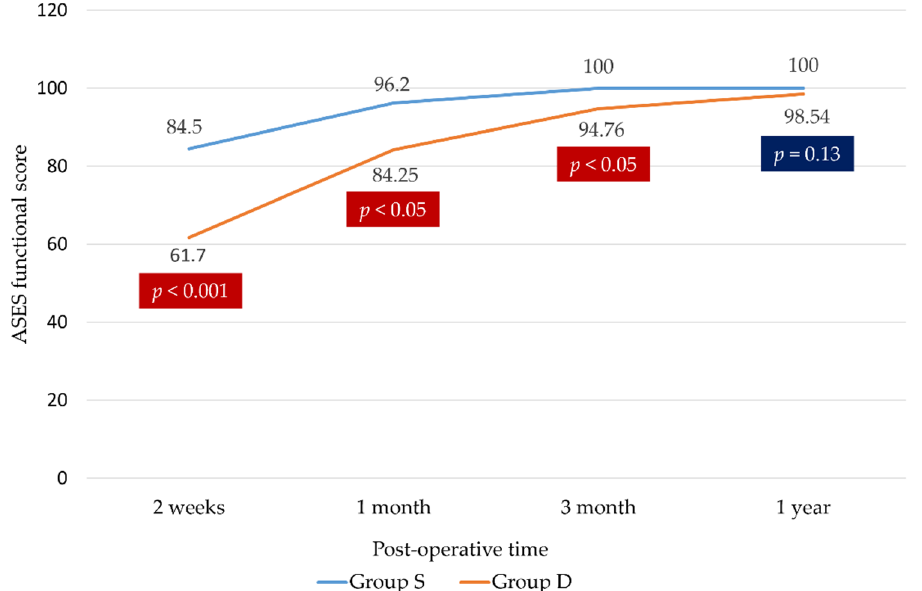
Figure 4. American Shoulder and Elbow Surgeons (ASES) score.